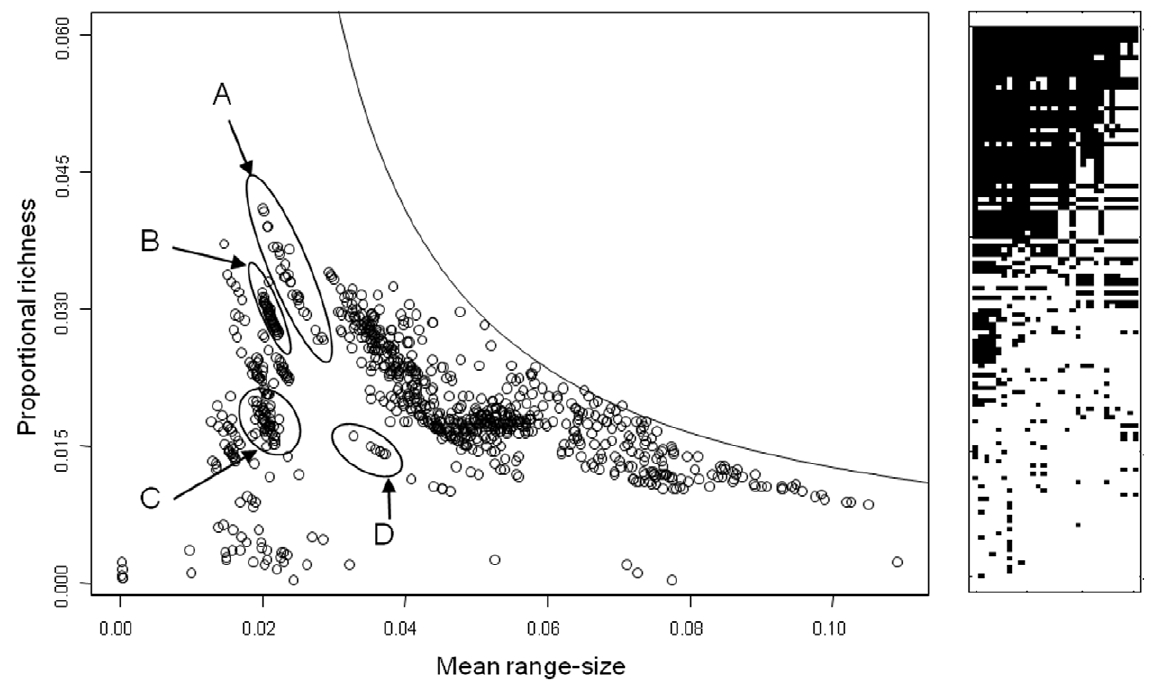
Figure 5. Range-diversity plot corresponding to different areas within the Indo-Malay zoogeographic region (left), and matrix plot of its PAM. The highlighted clusters in the RDP are: (A), Malay Peninsula, (B), Java, (C), Southern Borneo, (D), Sri Lanka. Line as in Figure (2) with parameters obtained from this cluster of points: t M =1.108 6 10 2 3 , b W =52.38. The PAM in the right is a matrix (202 species in rows and 29 cells in columns) of the Malay Peninsula cluster (A), showing its approximately nested pattern (a block of 80 species present in the entire peninsula was compacted to a single row).